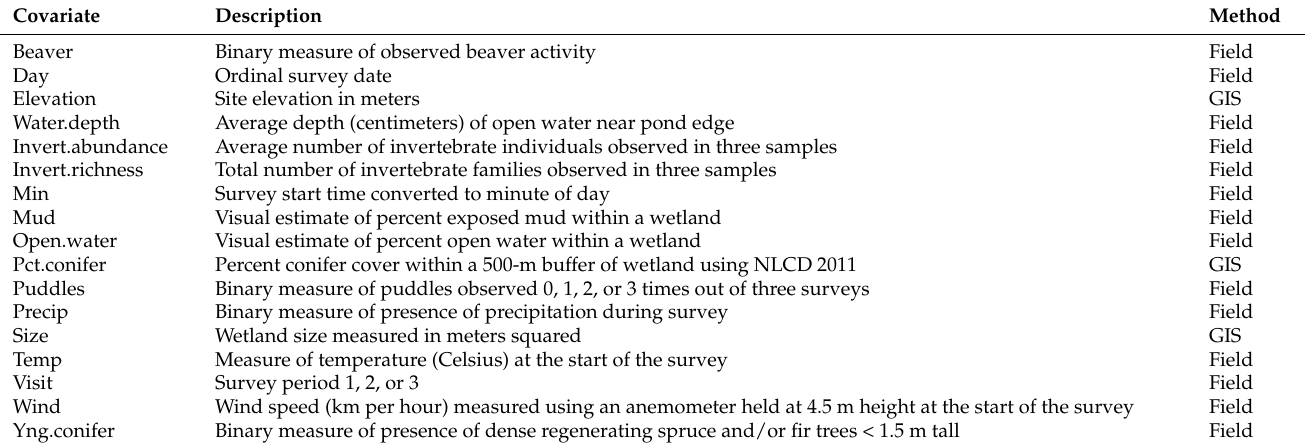
Table 1. Site and field survey covariates used to model detectability and site occupancy of Rusty Blackbirds in northern New England in 2014; the data collection method was by remote sensing (GIS) or at the site (Field).